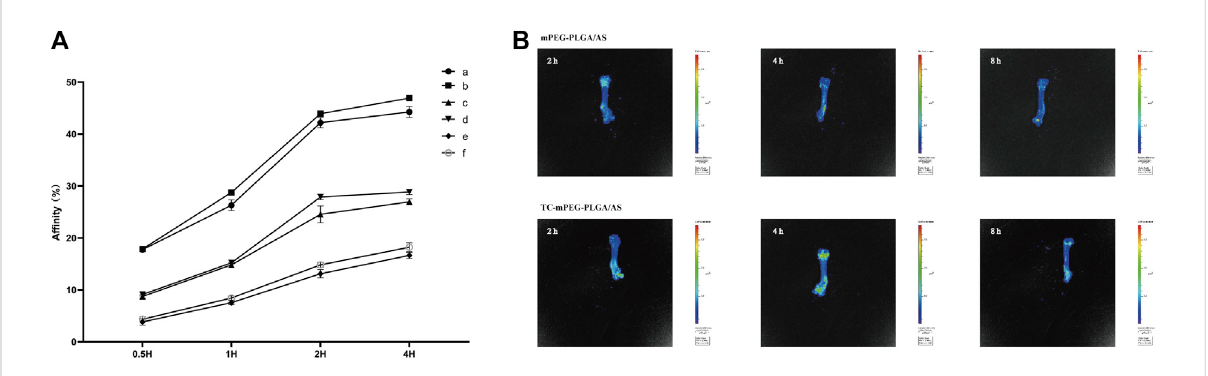
FIGURE 4 The results of hydroxyapatite targeting ability experiments (A) (a, AS-loaded TC ‒ mPEG ‒ PLGA micelles containing 5 mg AS; b, AS-loaded TC ‒ mPEG ‒ PLGA micelles containing 1 mg AS; c, AS-loaded mPEG ‒ PLGA micelles containing 5 mg AS; d, AS-loaded mPEG ‒ PLGA micelles containing 1 mg AS; e, free AS containing 5 mg AS; F, free AS containing 1 mg AS) and a fl uorescent in vivo imaging of AS-loaded mPEG ‒ PLGA micelles and AS- loaded TC ‒ mPEG ‒ PLGA micelles (B)